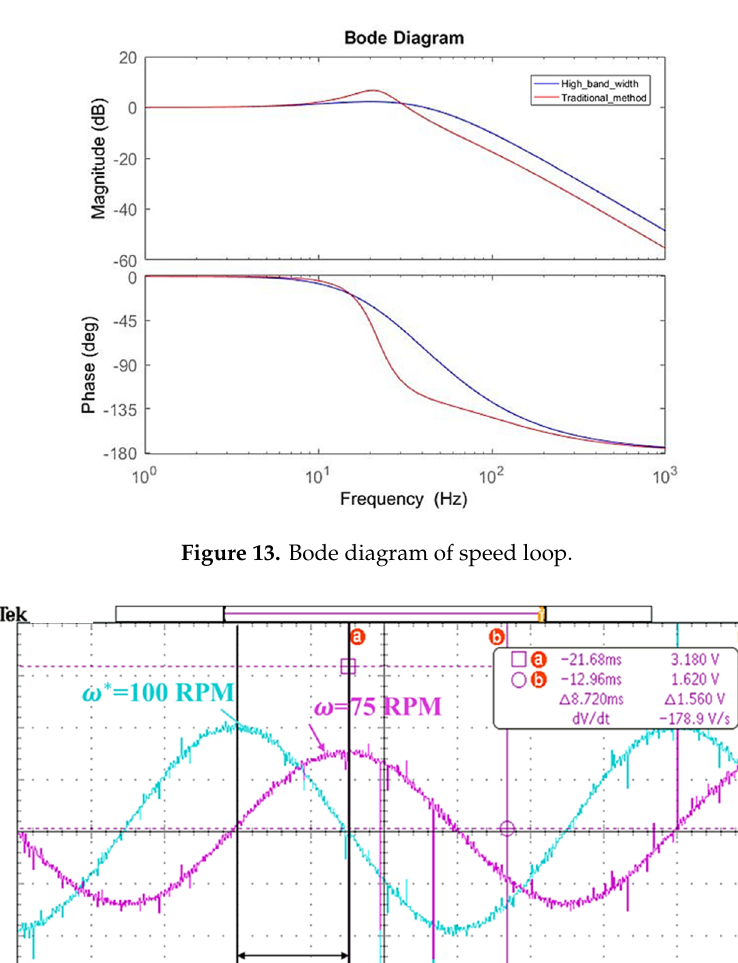
Figure 15. Speed loop step response. Table 4. Speed loop step response parameter. Traditional Method